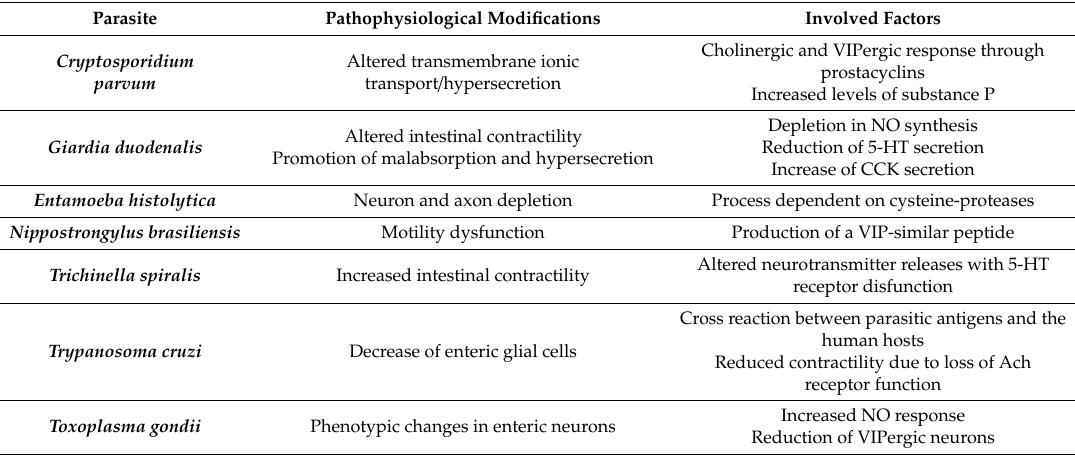
Table 3. Parasites and the enteric nervous